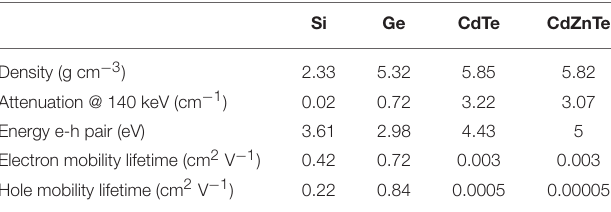
TABLE 5 | Physical properties of some semiconductor detectors used in medical imaging applications (adapted from Peterson and Furenlid [80]).